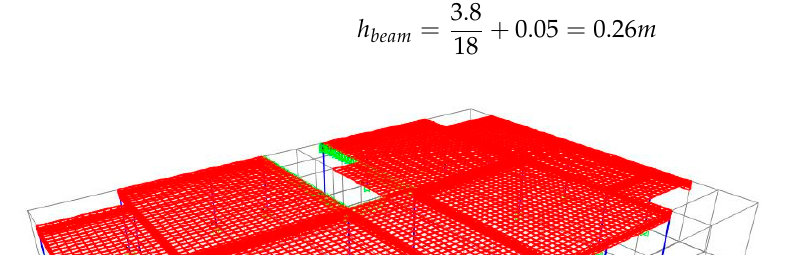
Table 4. Data to calculate beam height to verify indirect deformation, according to EC2.